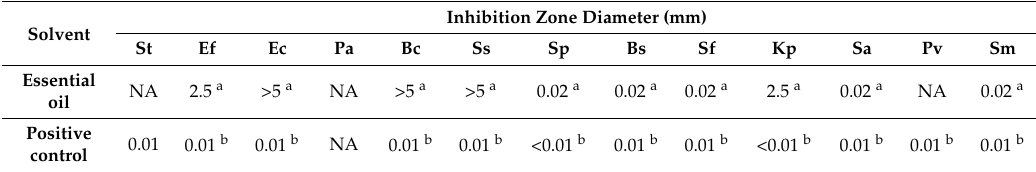
Table 2. Minimum inhibitory concentrations (MIC) of the H. africana essential oils against the tested opportunistic bacteria.